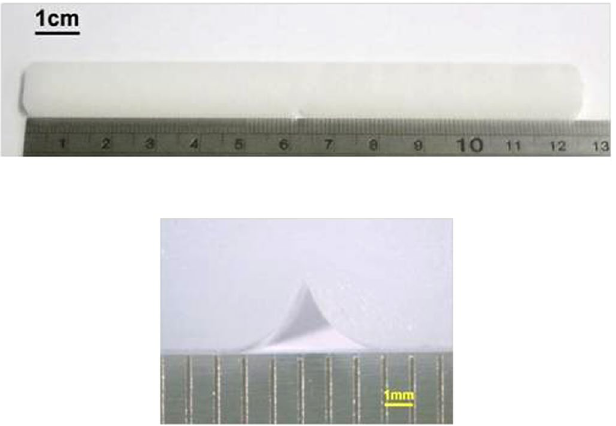
Figure 1. Image of HDPE tensile test specimen with moulded-in blunt notch from the tip of which sharp crack can also be made by a razor blade.